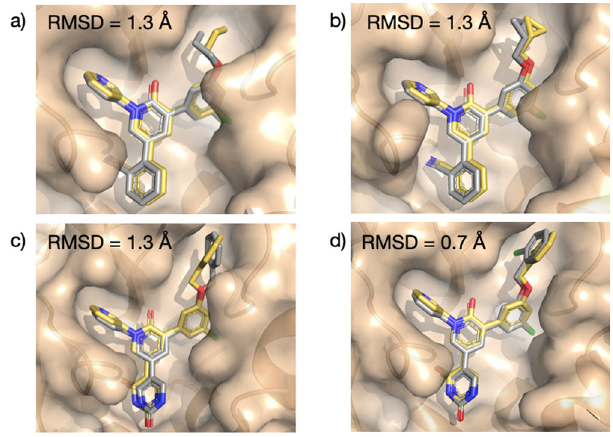
Fig. 5 Comparison between free energy calculations and experiment. Binding free energies of 13 analogues of the uracil-based M pro inhibitors, relative to compound 10. The error bars indicate one standard error based on least square fi tting 75